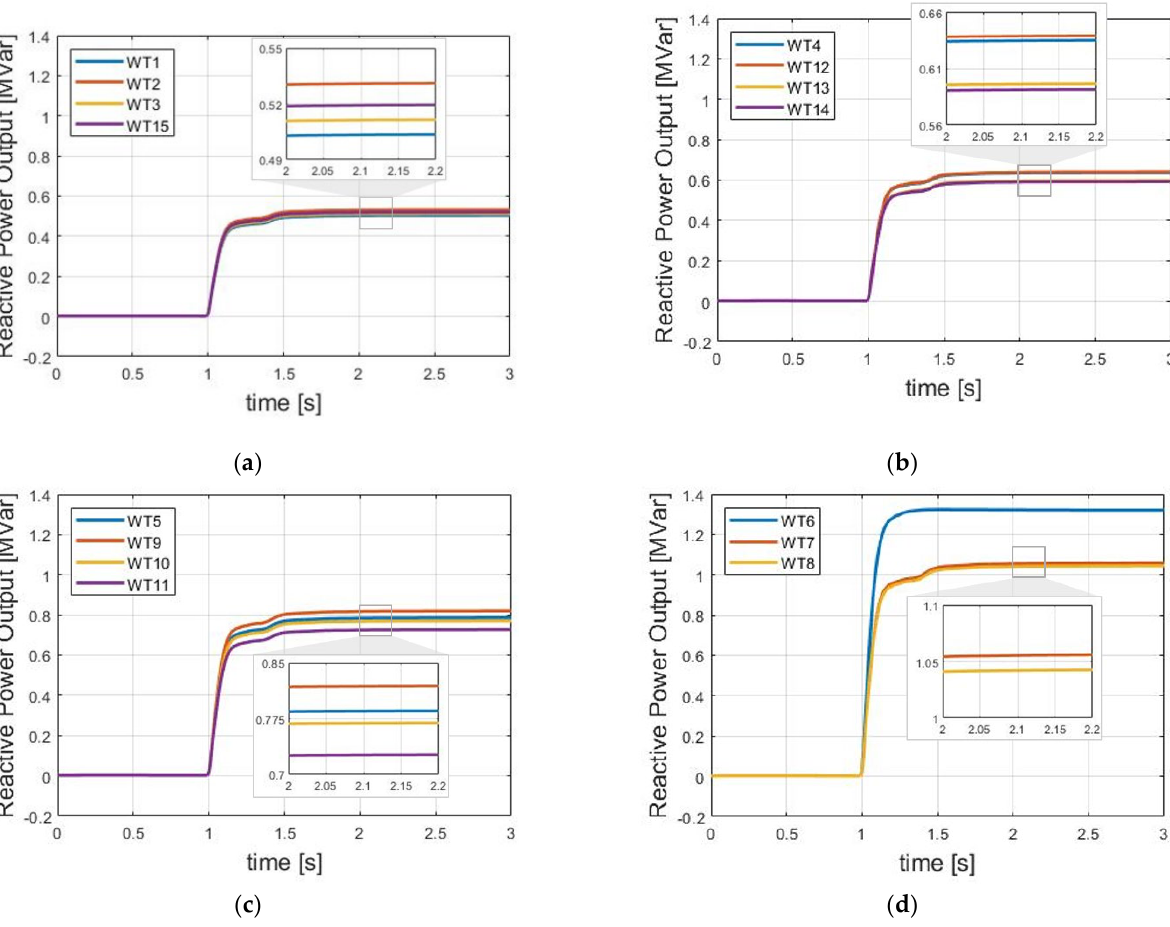
Figure 8. The reactive power outputs of wind turbines ( a ) array 1; ( b ) array 2; ( c ) array 3; ( d ) array 4